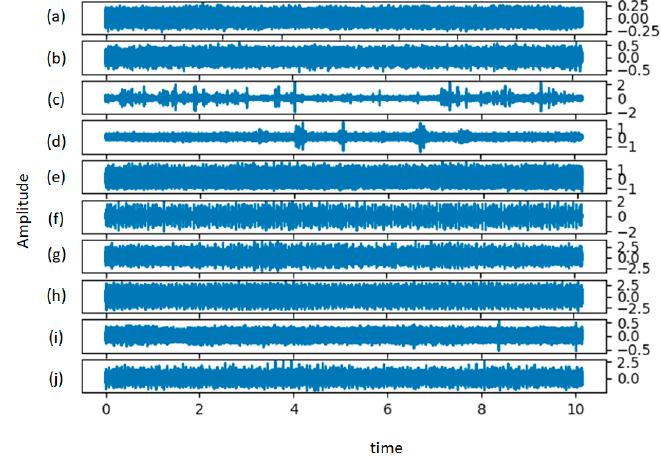
Figure 5. Raw data for ( a ) the normal for condition, ( b ) BF-007, ( c ) BF-014, ( d ) BF-021, ( e ) IF-007, ( f )